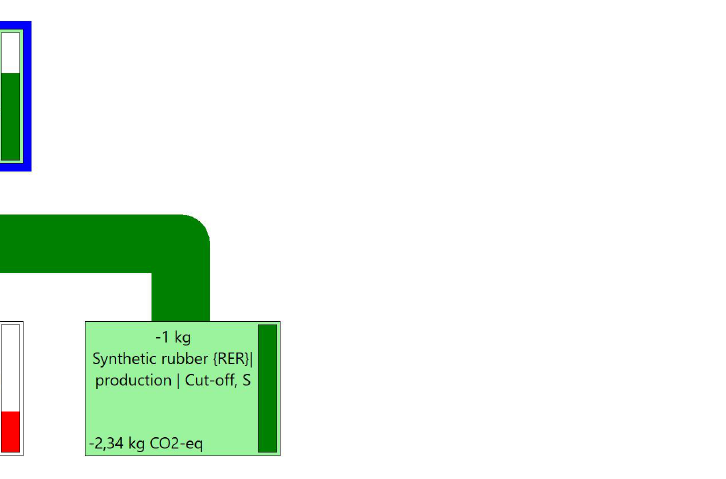
Figure 11. SimaPro network of the recycling process of 1 kg of waste tire rubber. The contribution in terms of GWP is expressed at the bottom of each sub-process.